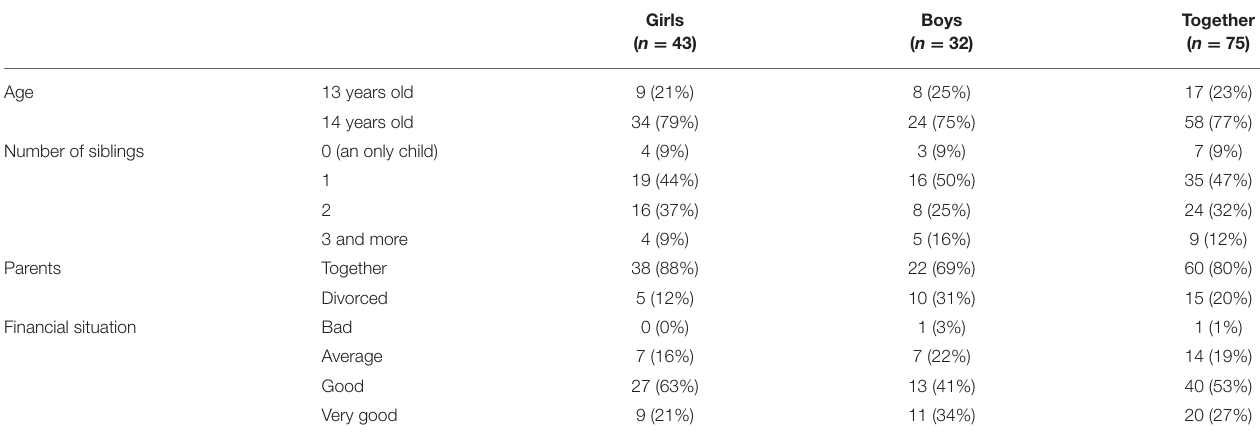
TABLE 1 | Selected characteristics of the study group ( n =